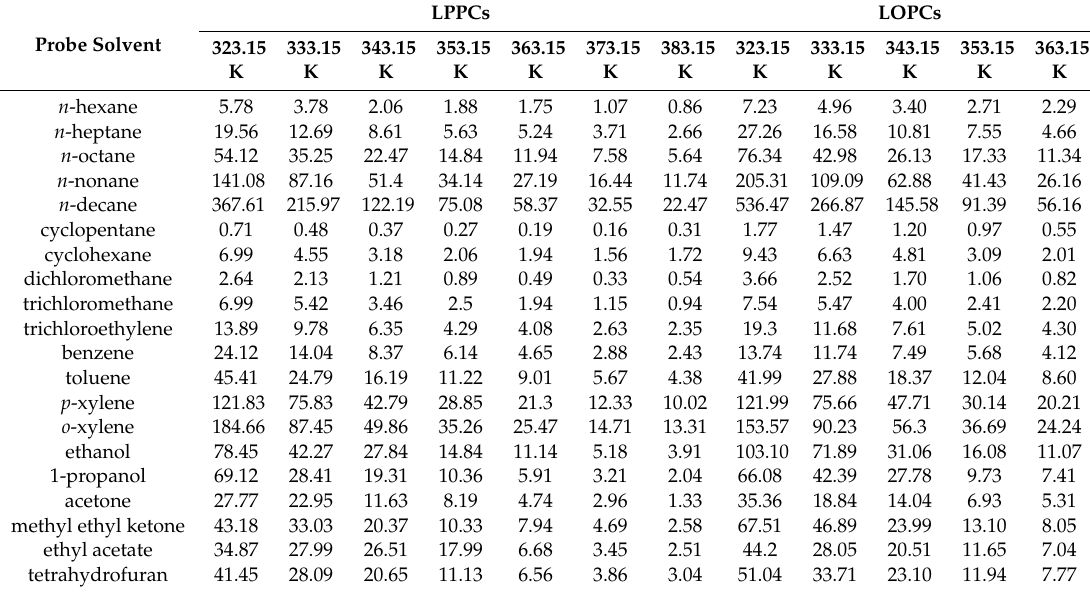
Table A2. Specific retention volumes V 0 g at di ff erent temperatures (mL / g).